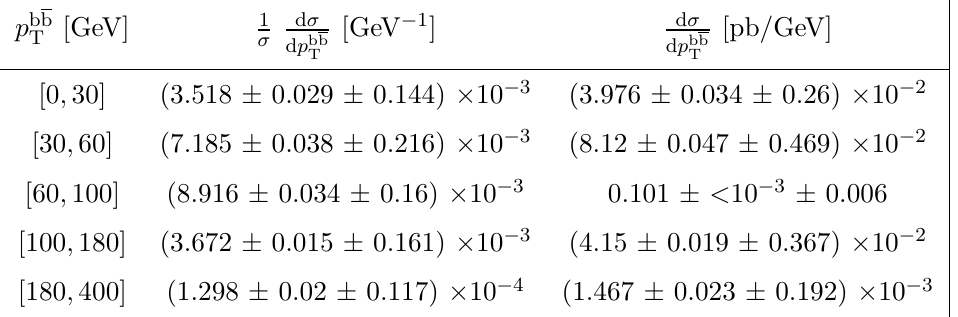
Table 45 . The measured di(cid:11)erential cross section and bin boundaries for each bin of the normalized and absolute measurements of the tt di(cid:11)erential cross section at particle level in the (cid:12)ducial phase space as a function of p bb are tabulated. T